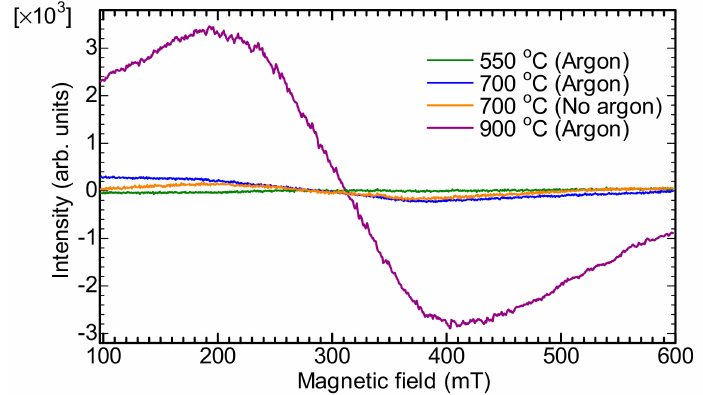
Figure 7. Electron spin resonance (ESR) analysis of the carbonized B. braunii residue at different temperatures and